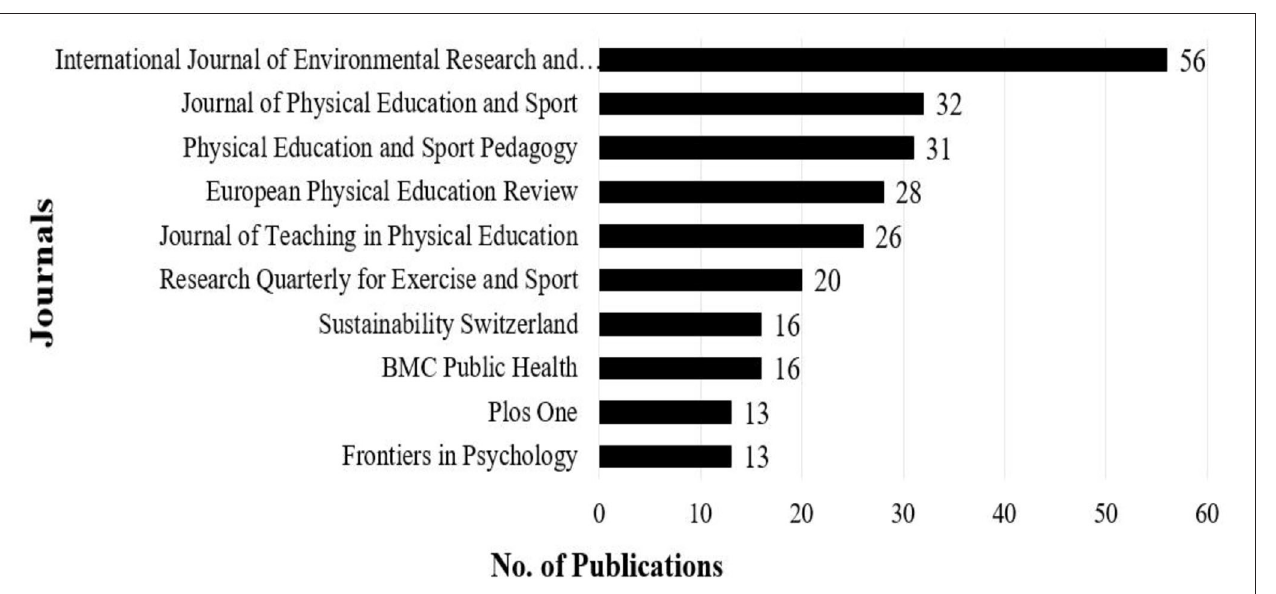
FIGURE 5 | Top 10 leading journals with